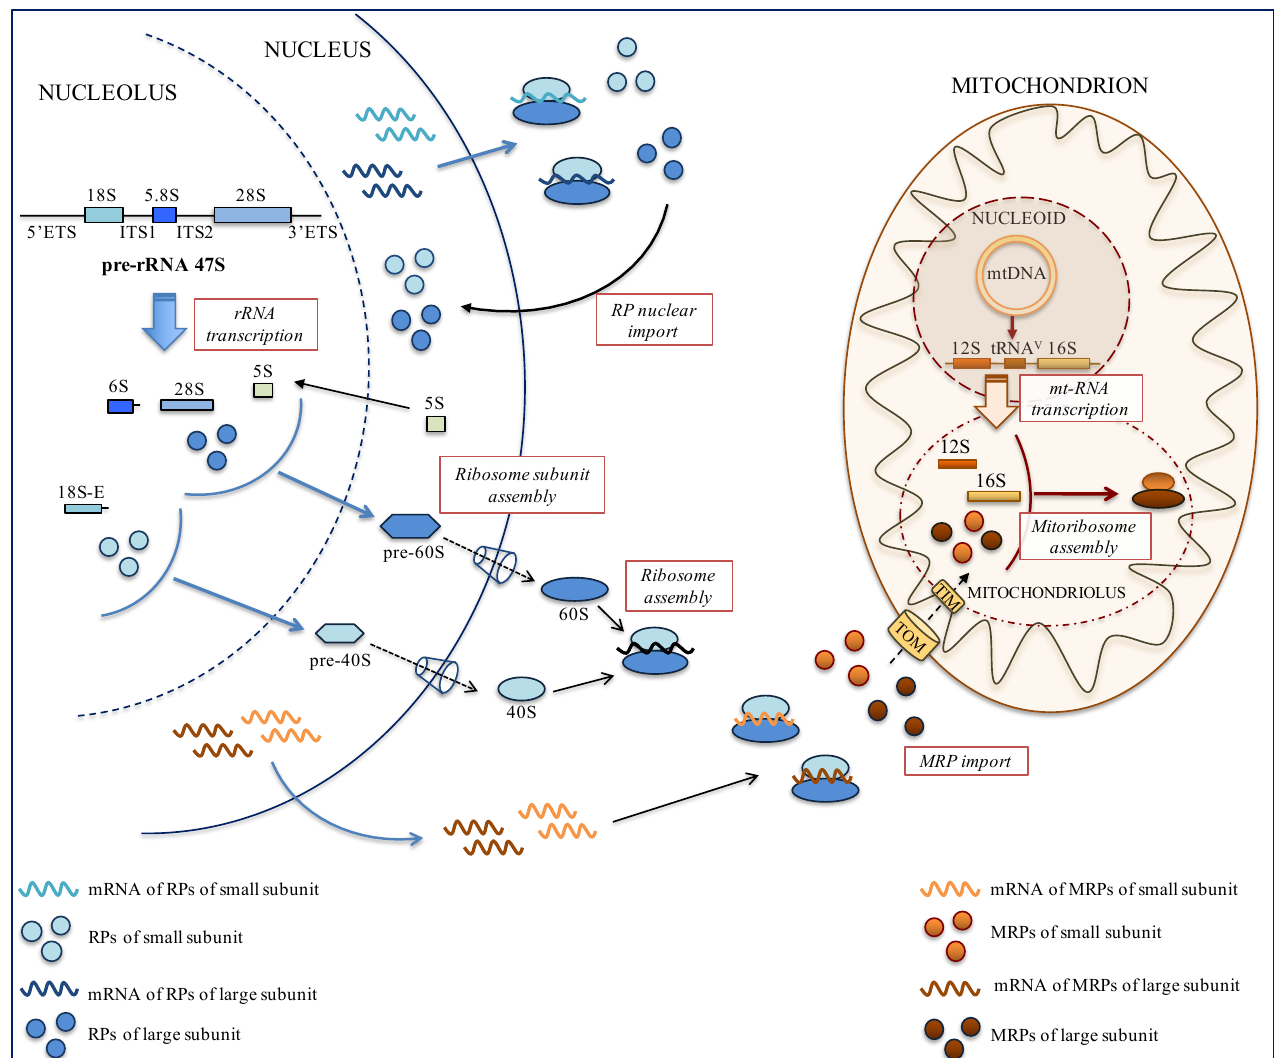
Figure 1. Schematic representation of cytosolic and mitochondrial ribosome